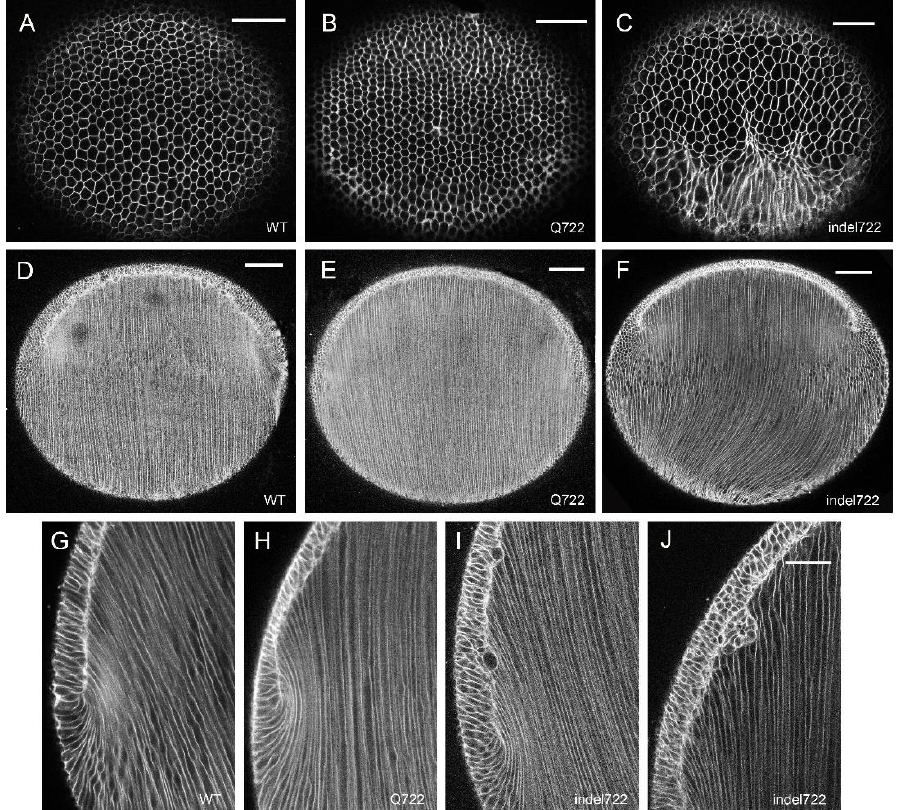
Figure 3. Whole-mount imaging of epithelial-to-fiber cell alignment in Epha2 -mutant lenses. Repre- sentative superficial (10–20 µ m depth) equatorial images ( A – C ), intermediate (100–150 µ m depth) equatorial images ( D – F ), and deep (300–400 µ m depth) equatorial images ( G – J ) of wild-type ( A , D , G ), Epha2 -Q722 ( B , E , H ), and Epha2 -indel722 ( C , F , I , J ) lenses (P7). Scale bar: 50 µ m ( A – C , G – J ), 100 µ m ( D – F